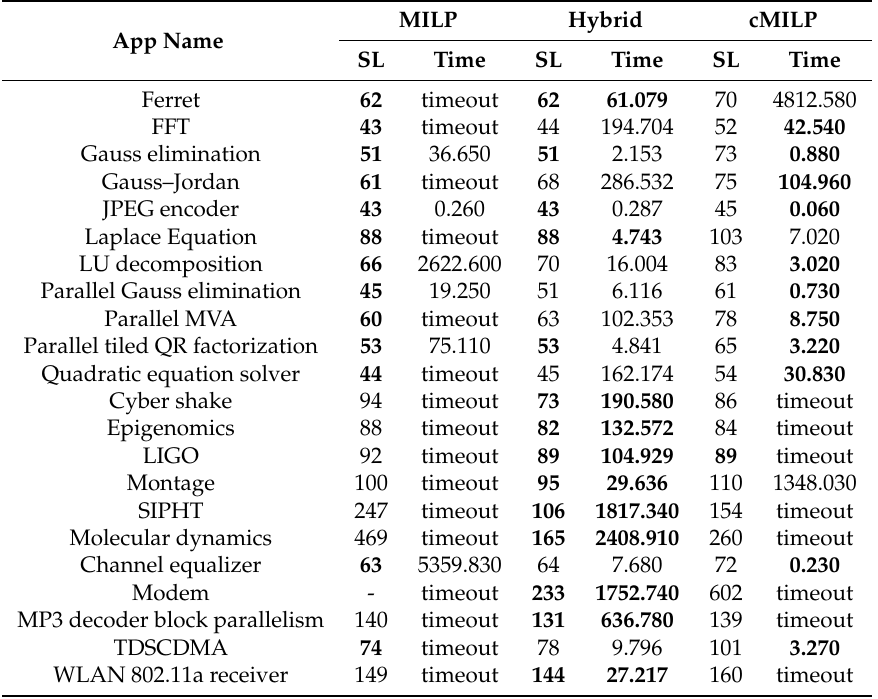
Table 5. Sw/Hw partitioning and scheduling result of the set of real applications on the platform with 50%